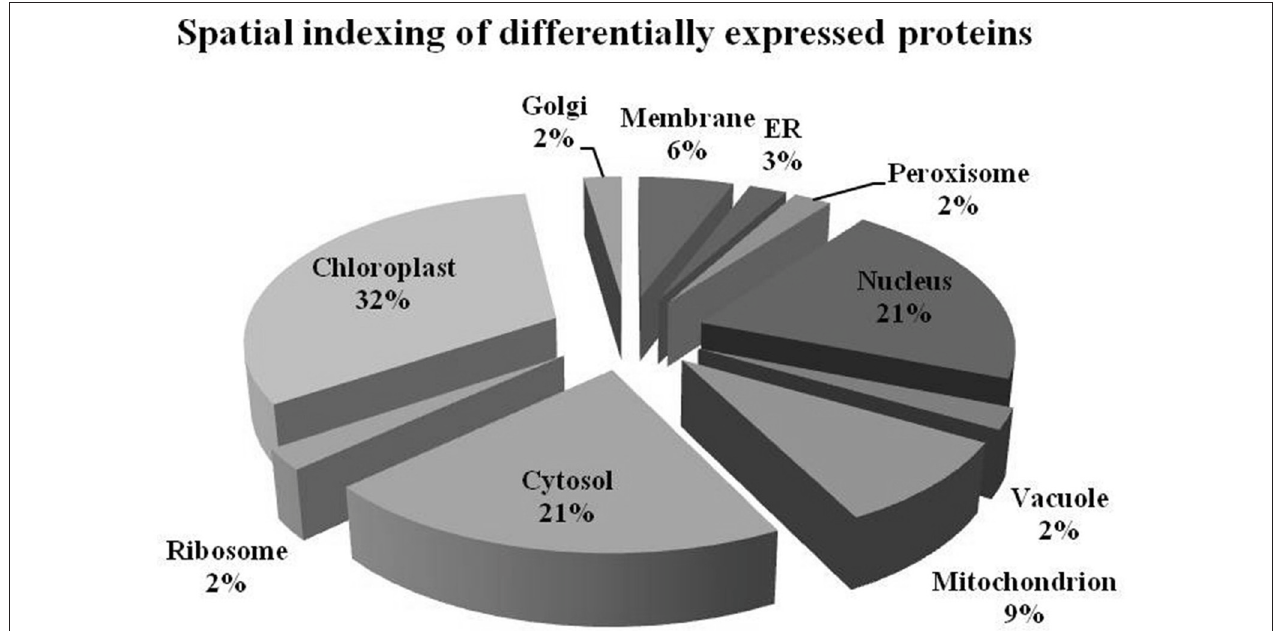
FIGURE 4 | Pie diagram depicting the spatial distribution of differentially expressed proteins at subcellular